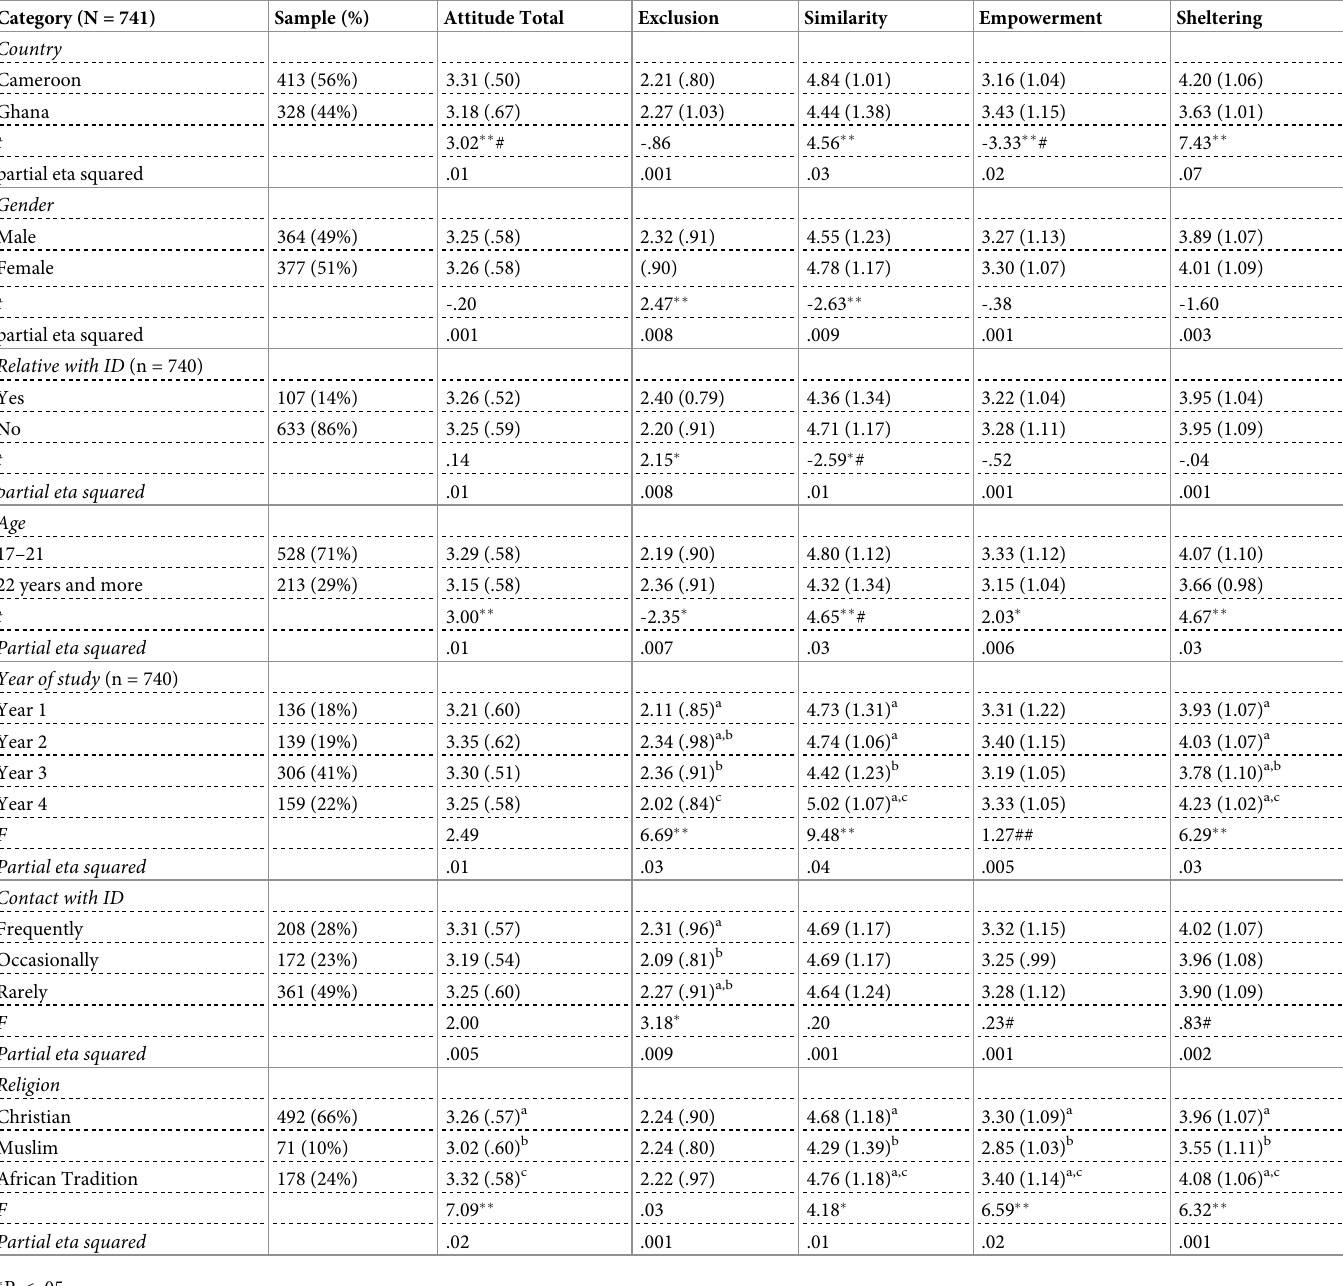
Table 3. Association between demographics and